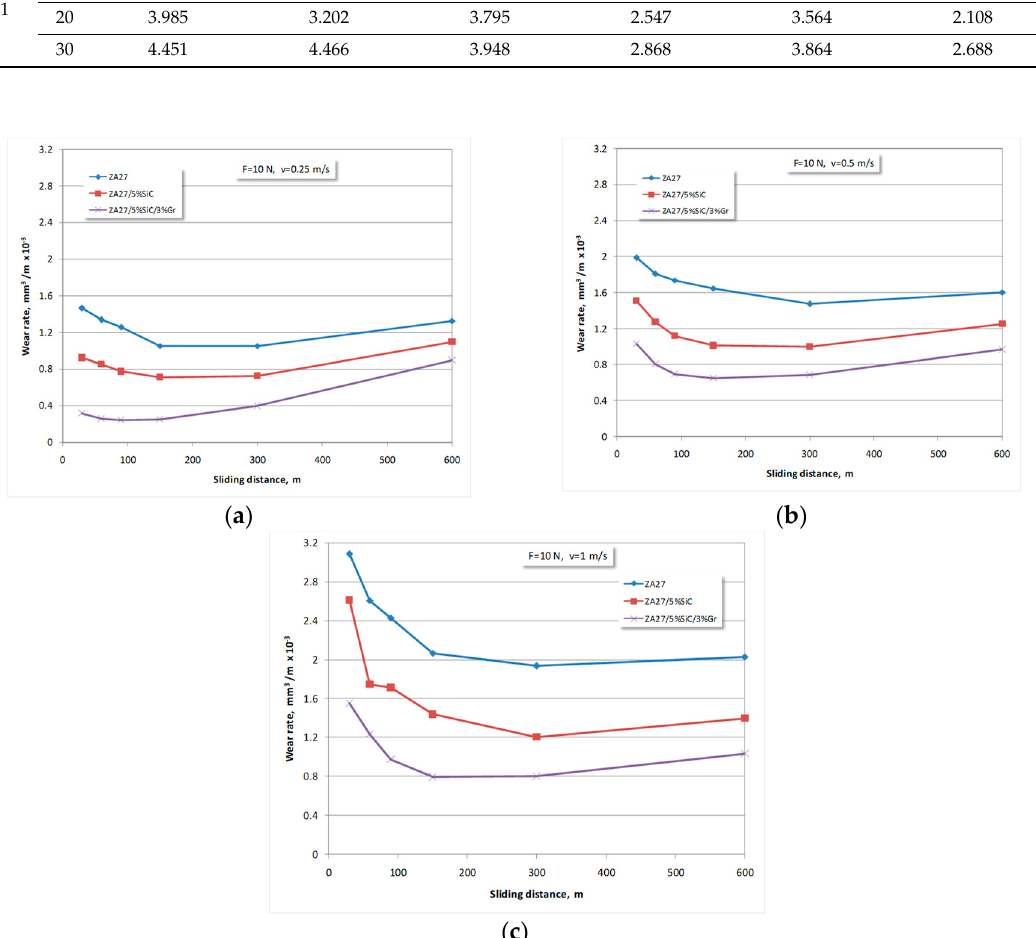
Figure 2. Wear-rate of the tested materials for normal load of 10 N and sliding speed of: ( a ) v = 0.25 m/s; ( b ) v = 0.5 m/s; ( c ) v = 1 m/s.